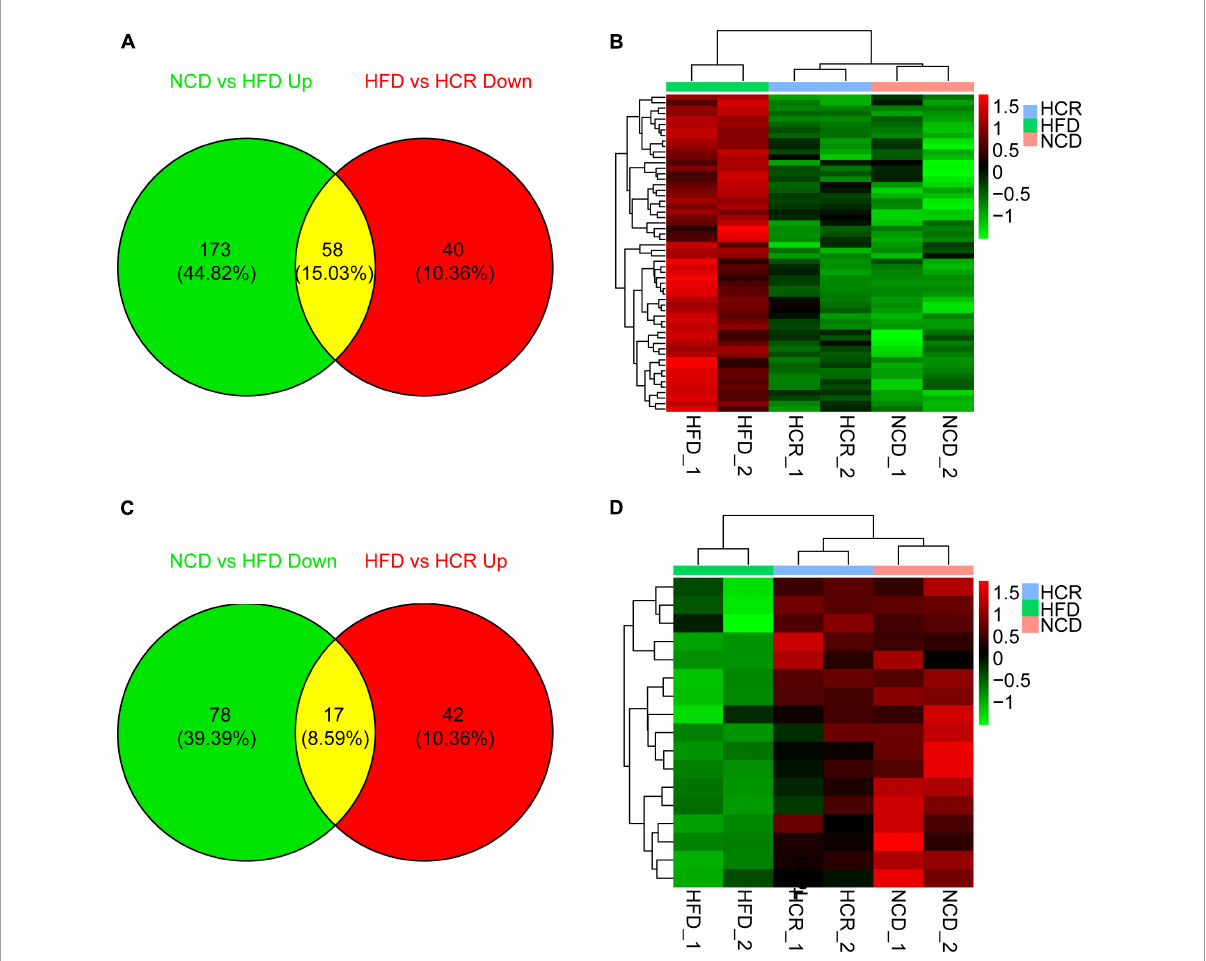
FIGURE4 Cori changed hepatic gene expression profiles in HFD-fed mice. (A) 58 down-regulated differently expressed genes (DEGs) by treatment with Cori, and (B) dendrograms of the corresponding DEGs in indicated groups. (C) 17 up-regulated differently expressed genes (DEGs), and (D) dendrograms of the corresponding DEGs by treatment with Cori in indicated groups. Group are shown in columns and genes in rows. Gene expression is indicated as a color, with brighter green and red for lower and higher values,